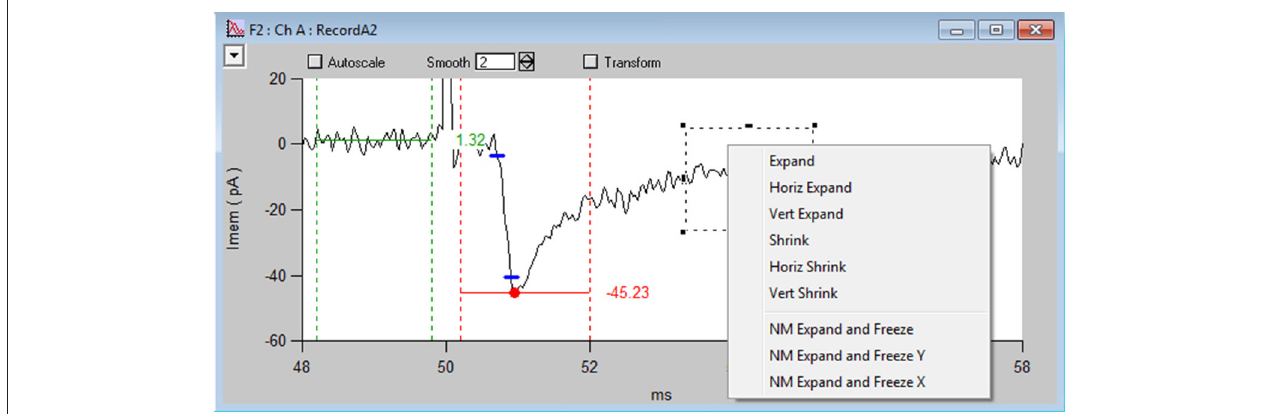
FIGURE 3 | NeuroMatic’s channel graph . Screen capture of the channel A graph (Ch A) for the Stats-tab rise-time analysis displayed in Figure 2 , showing a voltage-clamp recording (RecordA2, black line) acquired from the cell body of a granule cell (GC) in a cerebellar slice, where extracellular stimulation of a single mossy-fiber (MF) synaptic input at 50ms (see stimulus artifact, which has been clipped for display purposes) evoked an EPSC (inward current). Red circle and horizontal line denote the minimum of the EPSC computed within the dashed vertical red lines ( xbgn , xend ). An average baseline value (horizontal green line) has been computed before the EPSC within the dashed vertical green lines. Blue dashes denote where the EPSC reaches 10 and 90% of the peak amplitude from baseline. The time between these points is the 10–90% rise time (0.20ms). Data was filtered by a binomial smooth function (2 smoothing operations). Note, each channel graph has options to apply temporary transforms to the data (top) such as filter, baseline, normalize and differentiate. Various display options are listed within the top-left popup control, such as overlay, grid lines and axis scaling. More options are listed by clicking inside an Igor marquee (dashed square), created by clicking and dragging the mouse diagonally to frame a region of interest. Data was acquired via the Clamp tab from a cerebellar slice from a P24 mouse, where access resistance (R a ) = 14 M (cid:127) , membrane capacitance (C mem ) = 2.5 pF and the holding potential (V hold ) = −